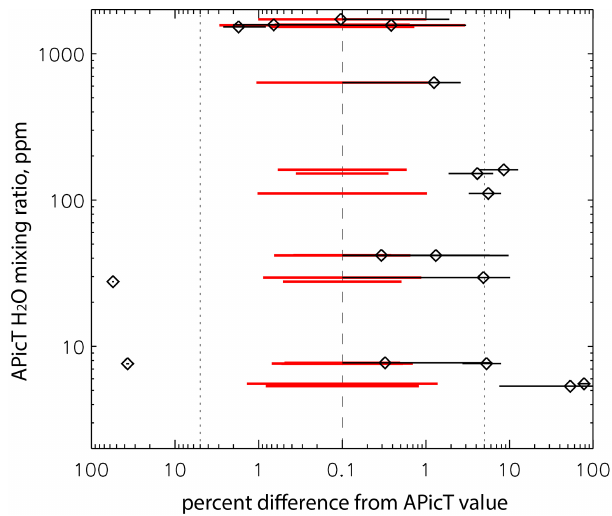
Figure A9. Comparison of SnowWhite and APicT during the sta- tionary segments during the second week’s dynamic experiments. Data analysis is as described in Sect. A8. The black symbols and error bars indicate segment averages and standard deviations. The red bars denote the APicT precision derived from the Gaussian fit. Dashed lines indicate the ± 5% error interval.